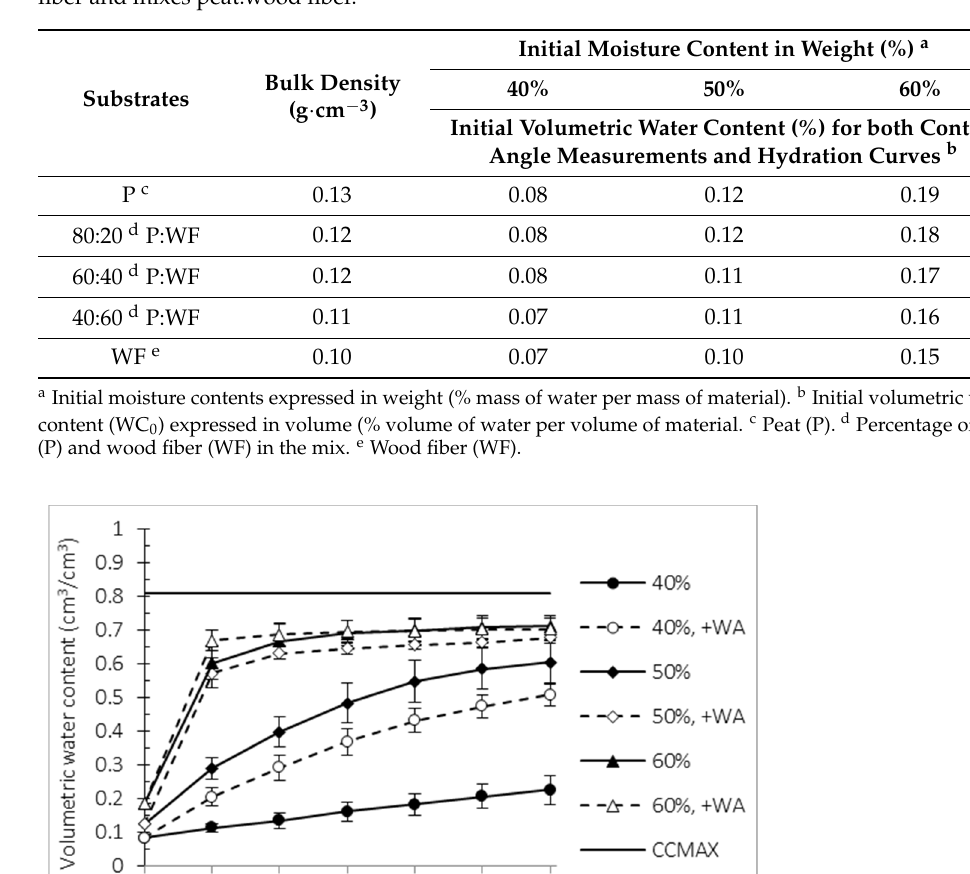
Table 1. Initial moisture contents expressed in weight and volumetric water contents for peat, wood fiber and mixes peat:wood fiber.